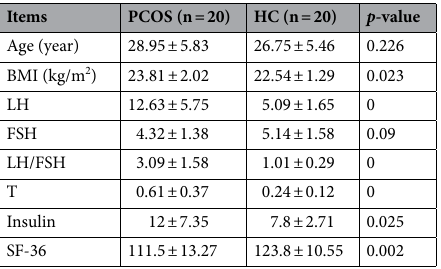
Table 1. Comparison of general information and serum hormone